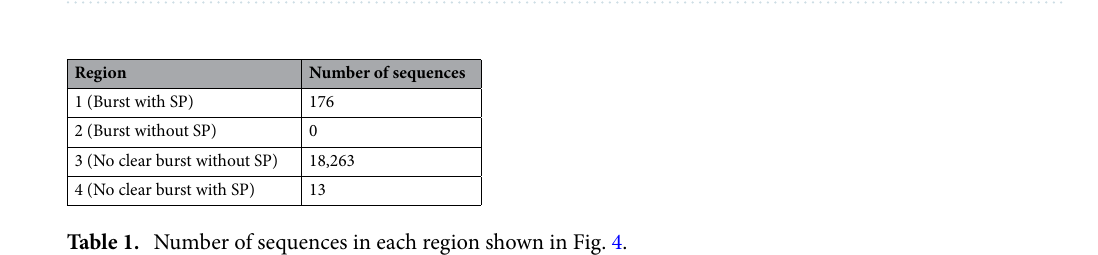
Figure 4. Statistical analysis of boundary burst and SP based on H